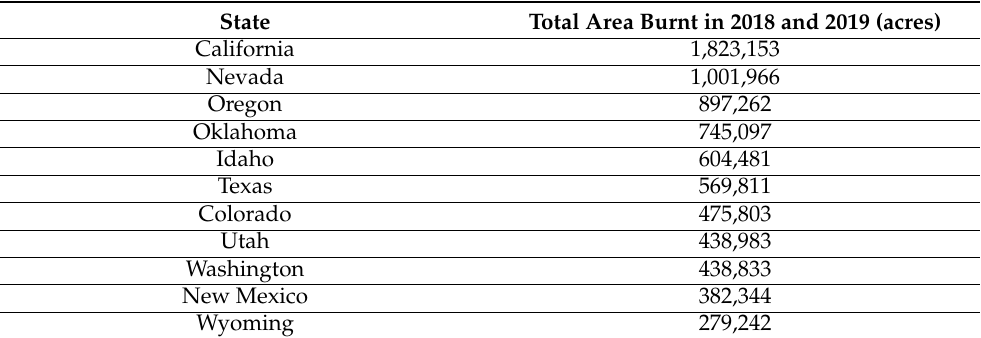
Table A3. Total area (acres) burnt for each state during the 2018 and 2019 year, obtained from the Wildfire Risk Report [12].